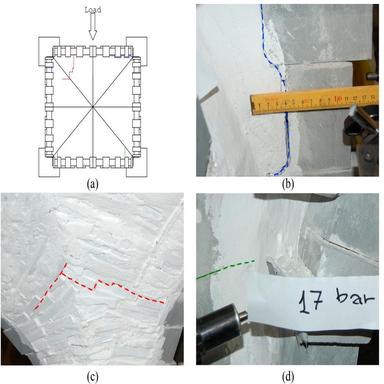
(a) Crack locations: intrados crack (red), extrados crack (green), through-thickness crack (blue); (b), (c) and (d) crack details. A more detailed discussion of the experimental results obtained can be found in . (For interpretation of the references to colour in this figure legend, the reader is referred to the web version of this article.)